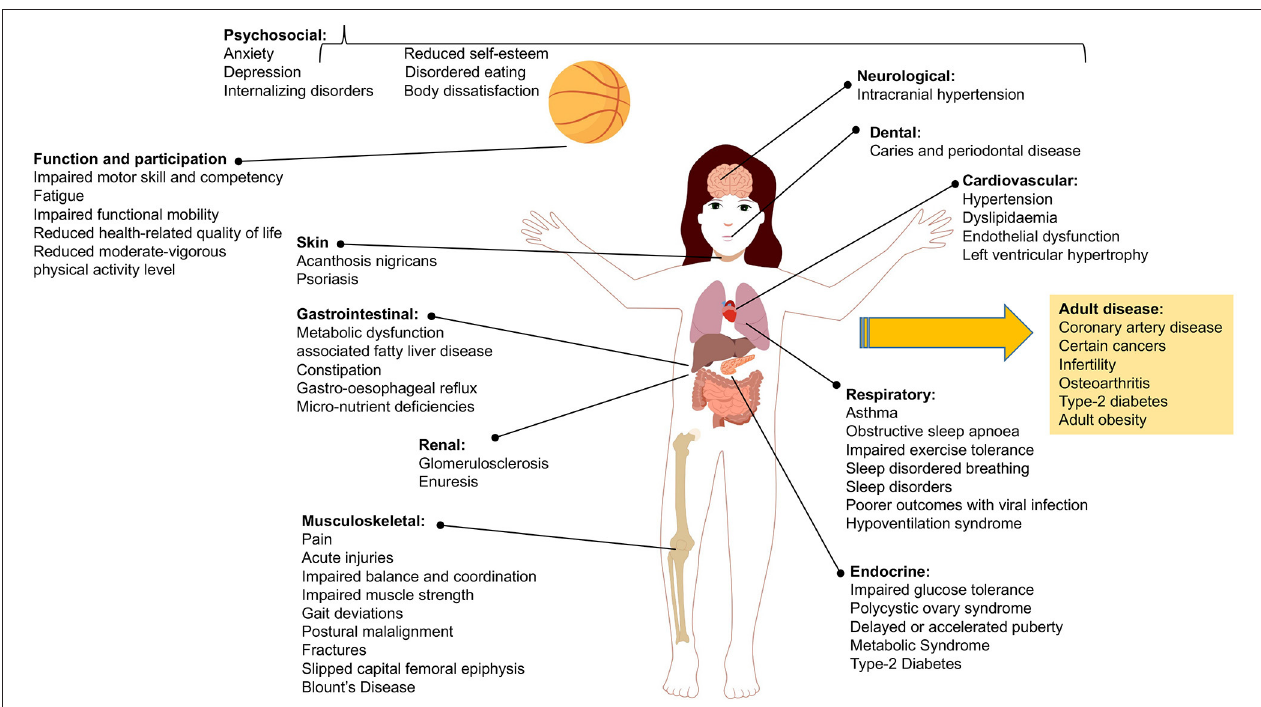
FIGURE 1 | Range of health complications and impairments associated with child and adolescent obesity including those diseases that are of increased risk in adulthood.